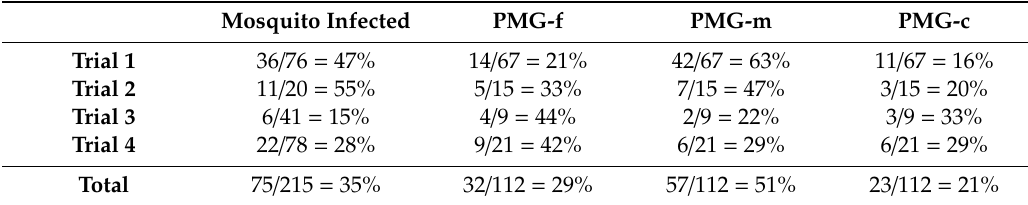
Table 1. Percent infection of mosquito MGs and distribution of SINV-associated GFP foci in midguts at day 7